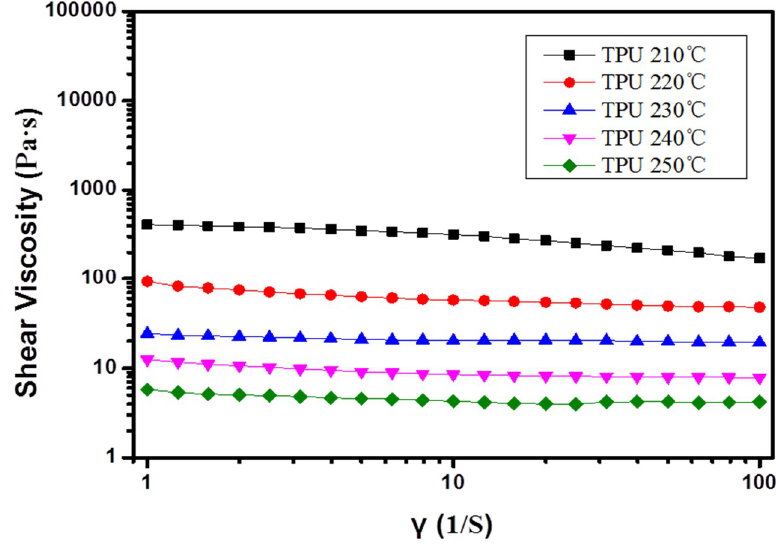
Figure 5. Rheological properties of TPU at different temperatures.